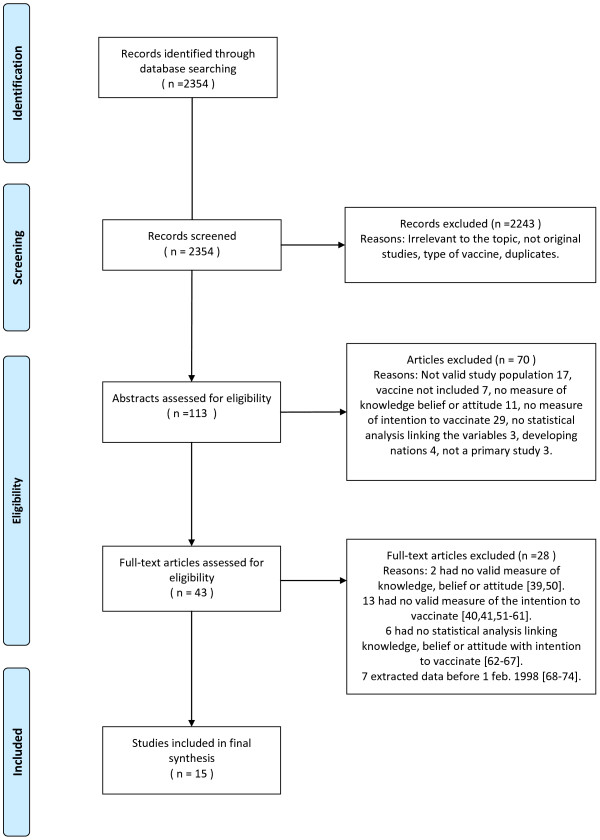
Flow chart of the reviewing process [39-41,50-74].